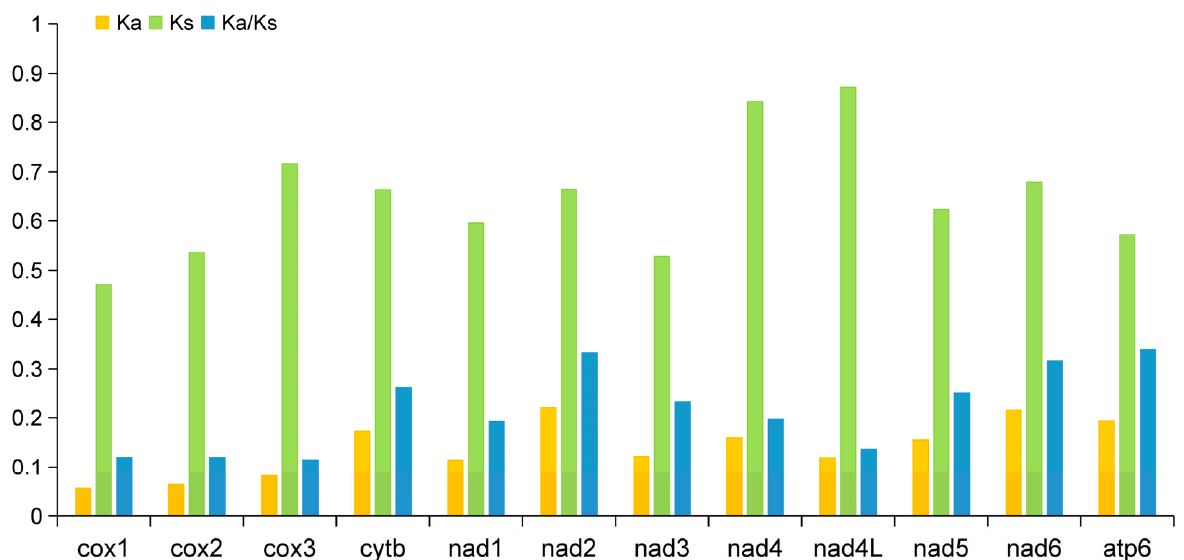
Figure 7. Evolutionary rates of PCGs between T. vitulorum and 28 other Rhabditida mitogenomes. The rates of non-synonymous substitutions (Ka) and synonymous substitutions (Ks) and the ratio of Ka/Ks are calculated for each PCG.